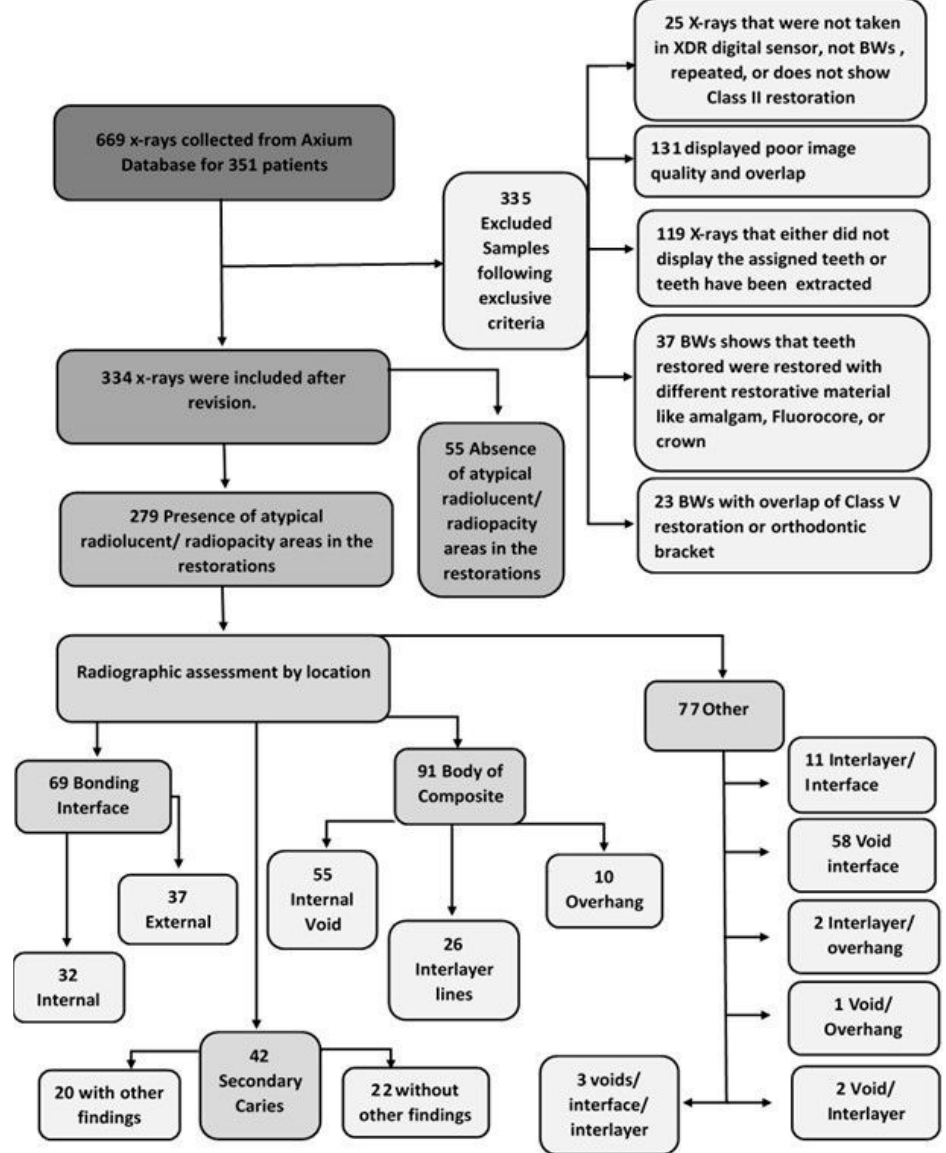
Figure 1. Flow chart showing the selection criteria and categorization of the findings used in this study.